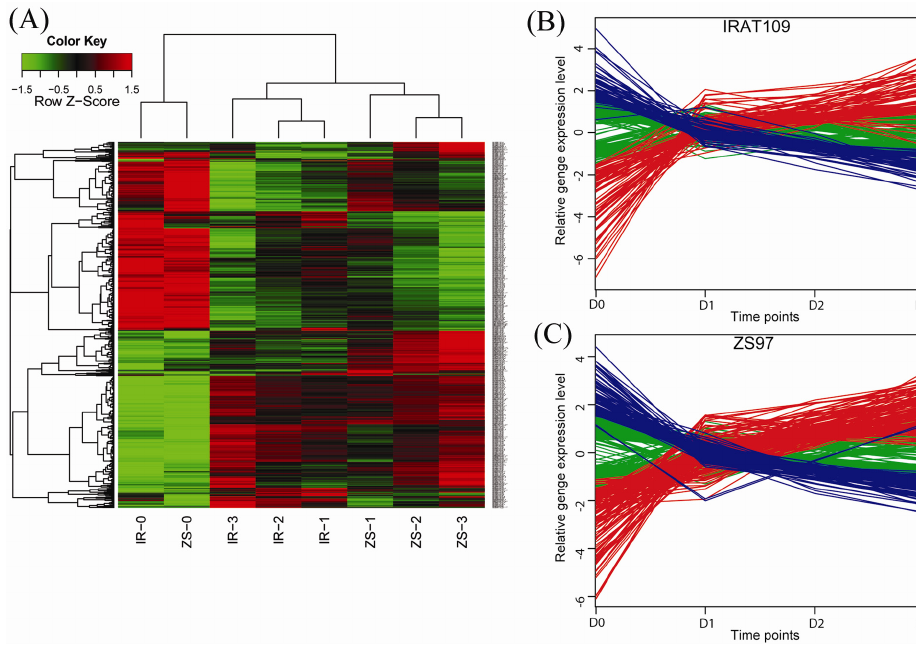
Figure 3. Differentially expressed genes during the time course of drought (D0 to D3). A total of 925 genes (625 in ZS97 and 320 in IRAT109) were differentially expressed among the four stages of drought stress. ( A ) Hierarchical clustering of differentially expressed genes based on the correlation coefficients of the relative gene expression values (Z-score) for each time point. Red and green indicate high and low expression levels; ( B , C ) Two groups of genes with opposite expression trends from D0 to D3 in IRAT109 and ZS97, respectively. The normalized expression levels (based on the ln-transformed mean of the four stages) of each gene are illustrated. The colored lines denote the expression profile of the genes: blue indicates a large decrease from D0 to D3 and red indicates a large increase and green indicates a small change. Stages: D0, before drought stress; D1, D2 and D3: three stages of drought